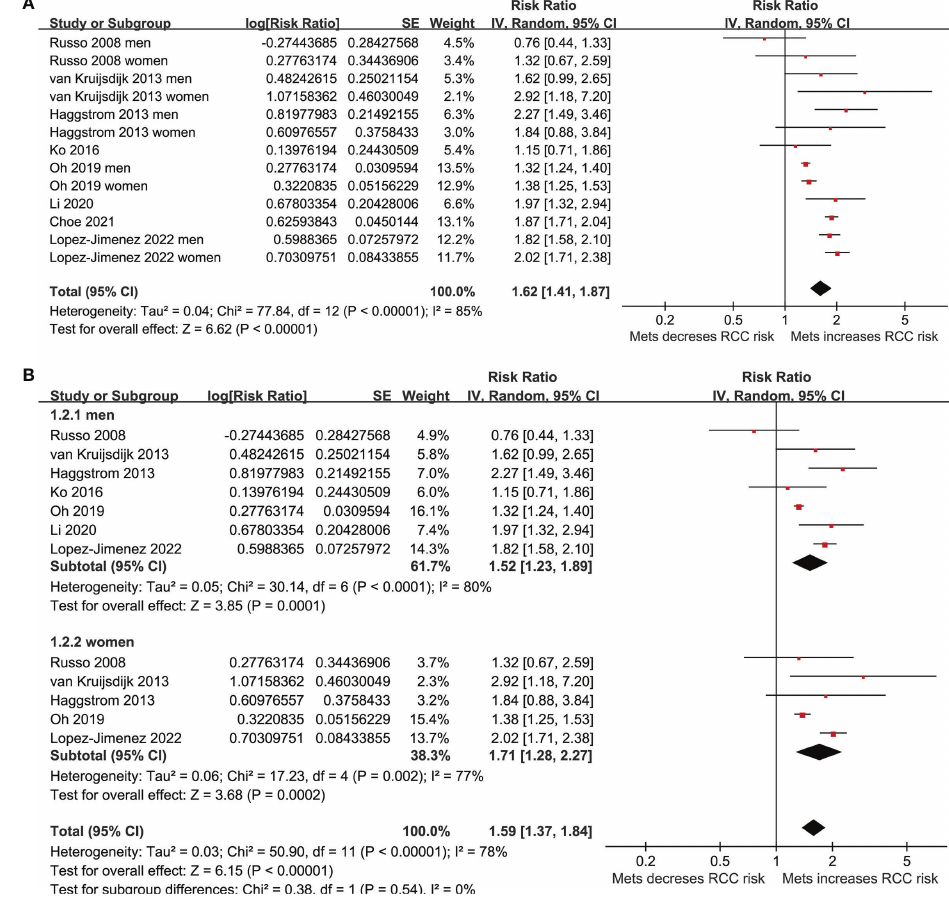
FIGURE 2 | Forest plots for the meta-analysis of the association between MetS and RCC. (A) , overall meta-analysis; and (B) , group analysis according to the sex of the